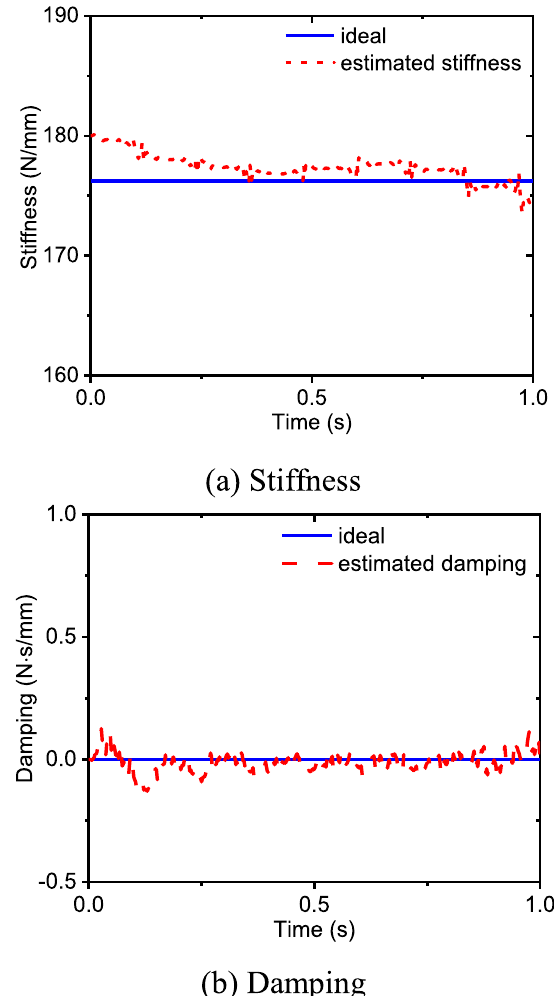
Figure 6 Estimated contact parameters in